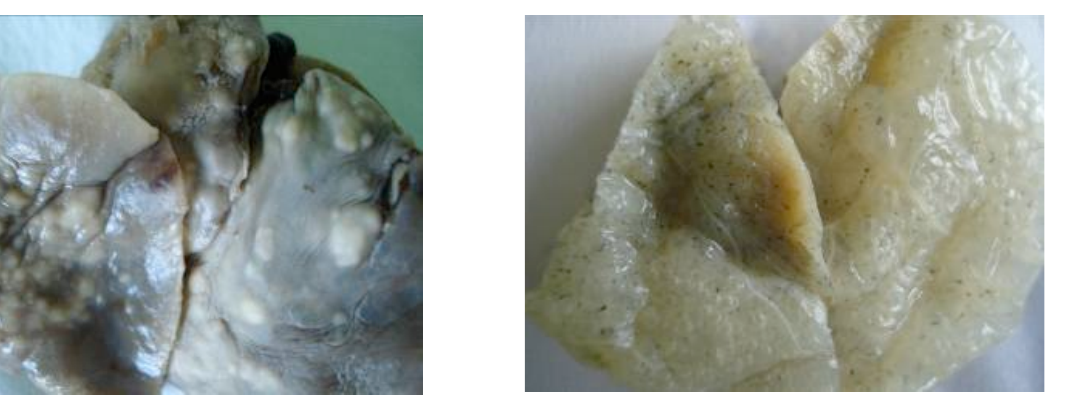
Image 3. Lung of Rhesus Macaque showing white caseous nodules and black-brown coloration